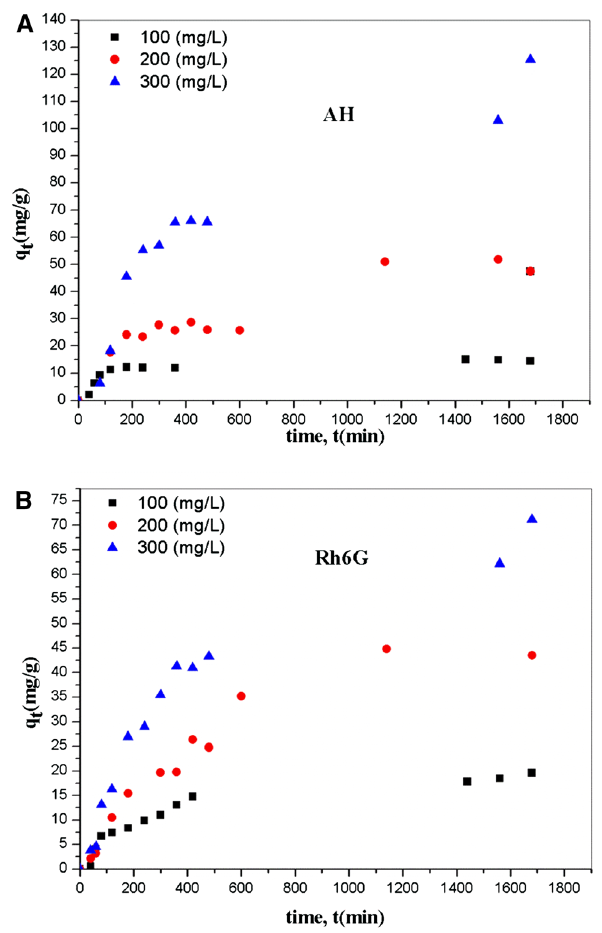
Fig. 9 Kinetic adsorption data for Rh6G ( a ) and HA ( b ) in mixture component systems on composite at various initial concentrations ( m = 200 mg, V = 200 cm 3 , T = 20 °C, pH = 3)